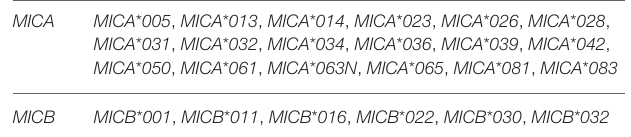
TABLE 2 | MICA/B alleles described in IPD/IMGT-HLA release 3.37.0, but never observed in our cohort of over two million